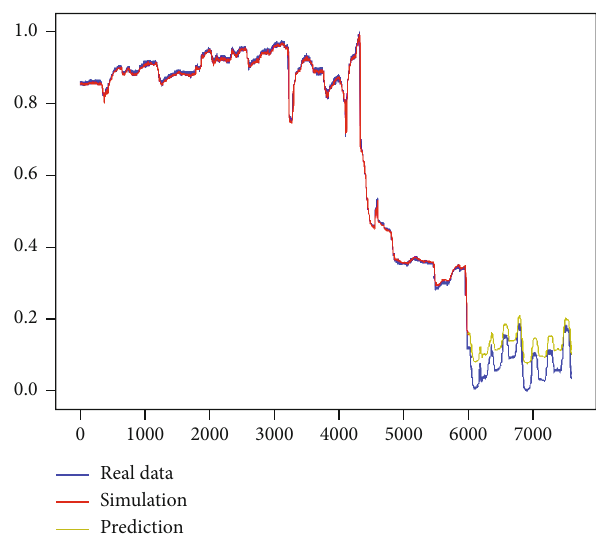
Figure 12: Curve of predicted data versus real data.